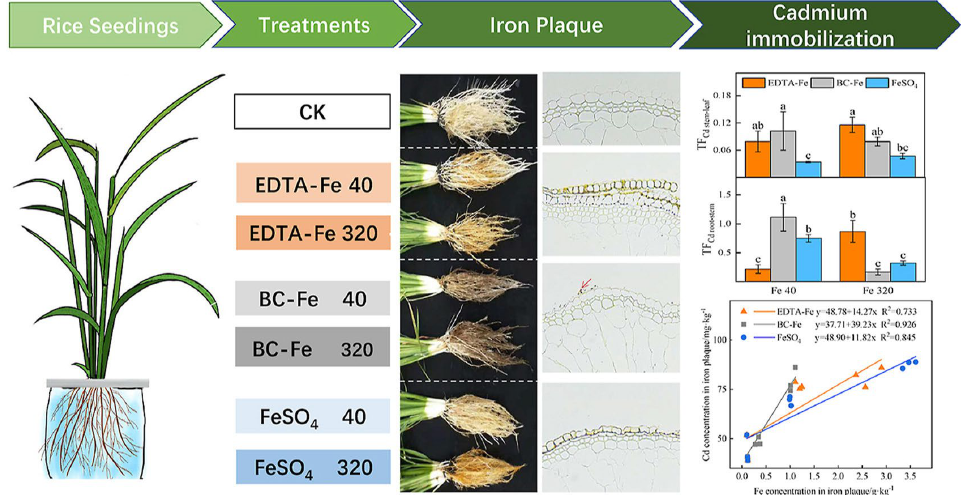
Figure 3. Nano-Fe 3 O 4 -modified biochar promotes Fe film formation and cadmium (Cd) fixation in rice roots. Different letters indicate a significant difference between treatments according to Duncan’s test ( p < 0.5). Reprinted with permission from Ref. [33]. 2021, Elsevier.